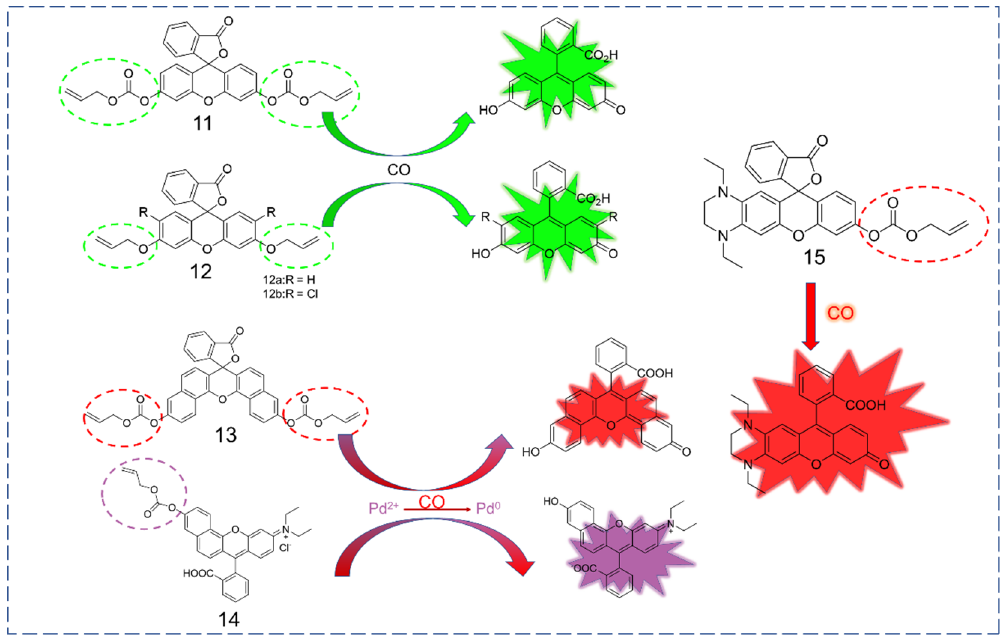
Figure 8. The chemical structures of some CO fluorescent probes constructed on the basis of